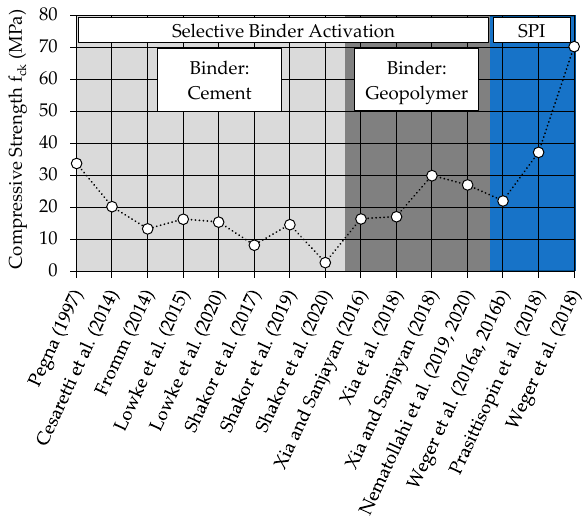
◦ for particle-bed-based methods [29].